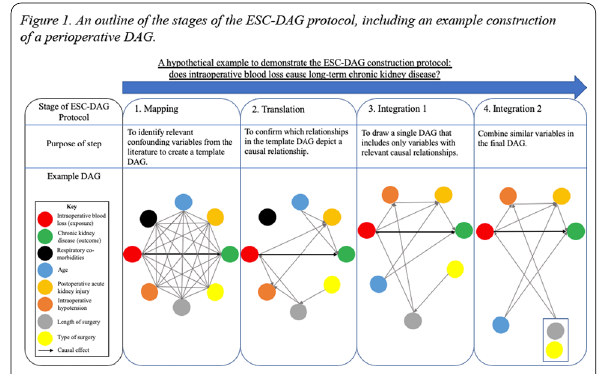
Figure 1. An outline of the stages of the ESC-DAG protocol, including an example construction of a perioperative DAG. Objectives: To assess whether DAGs in the observational periop- erative literature are constructed in accordance with the ESC-DAG protocol.